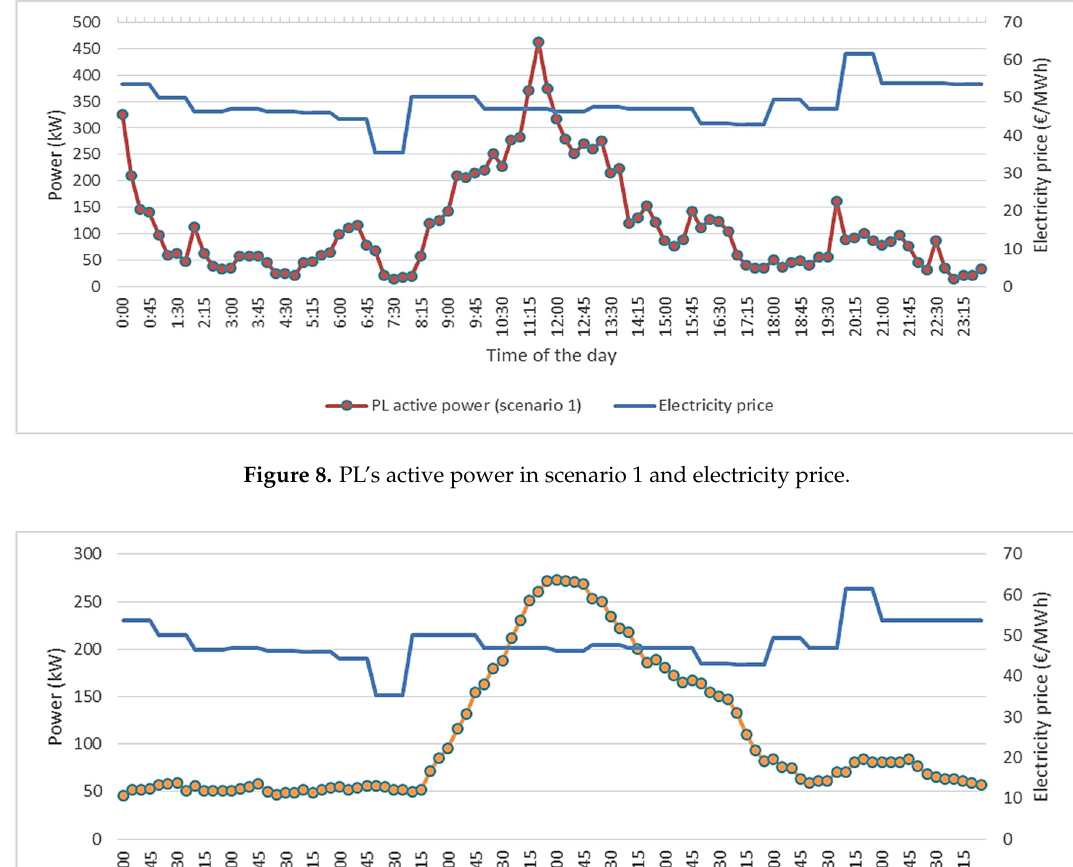
Figure 10. PL’s active power in scenario 3 and electricity price. Figure 11. PL’s active power in scenario 4 and electricity price.